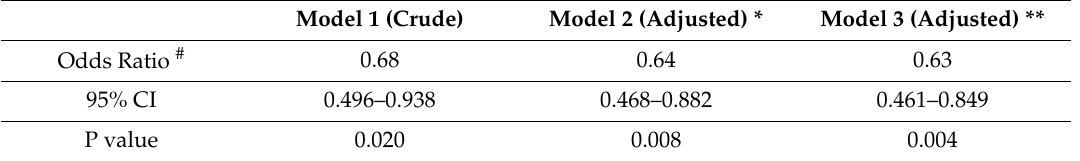
Table 2. The association between urban / rural residence and unmet need for family planning (FP) among 18–49-year-old married women in south and north Yangon